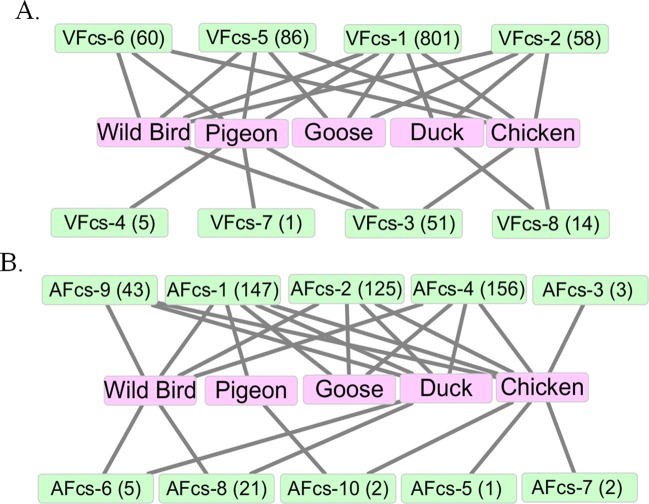
Relationship between Fcs variants and avian species.Birds except chicken, pigeon, goose and duck are considered wild birds. A. Virulent Fcs in avian species. B. Avirulent Fcs in avian species.